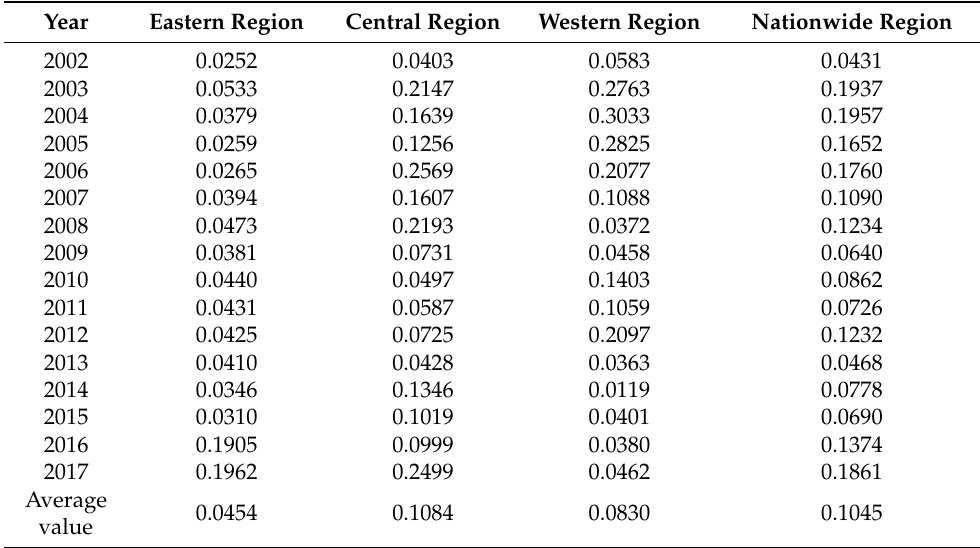
Table 6. σ convergence values for nationwide, eastern, central, and western